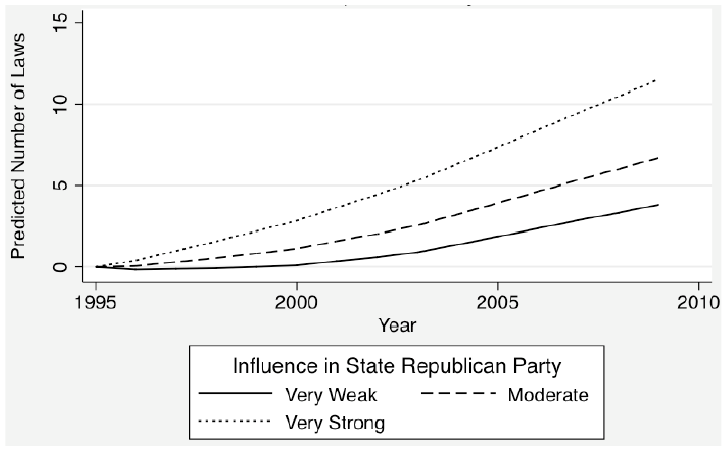
Figure 4. Predicted cumulative faith ‐ based legislation for states containing Christian right social movements with weak, moderate, & strong influence within the State Republican Party